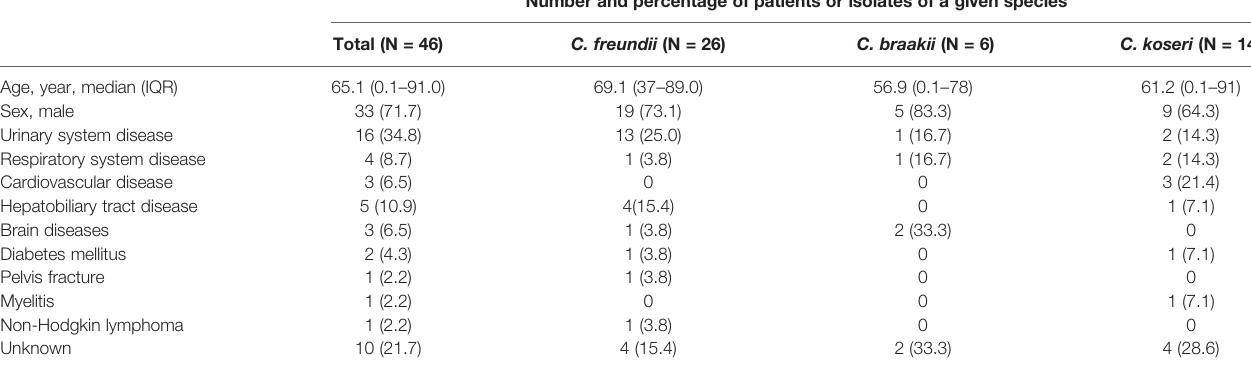
TABLE 1 | Clinical characteristics of the patients with Citrobacter infections. Number and percentage of patients or isolates of a given